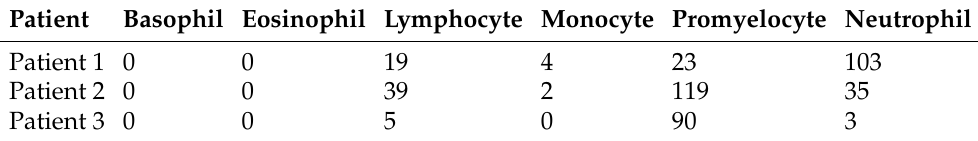
Table 12. The number of six types of leukocytes extracted from three patients.